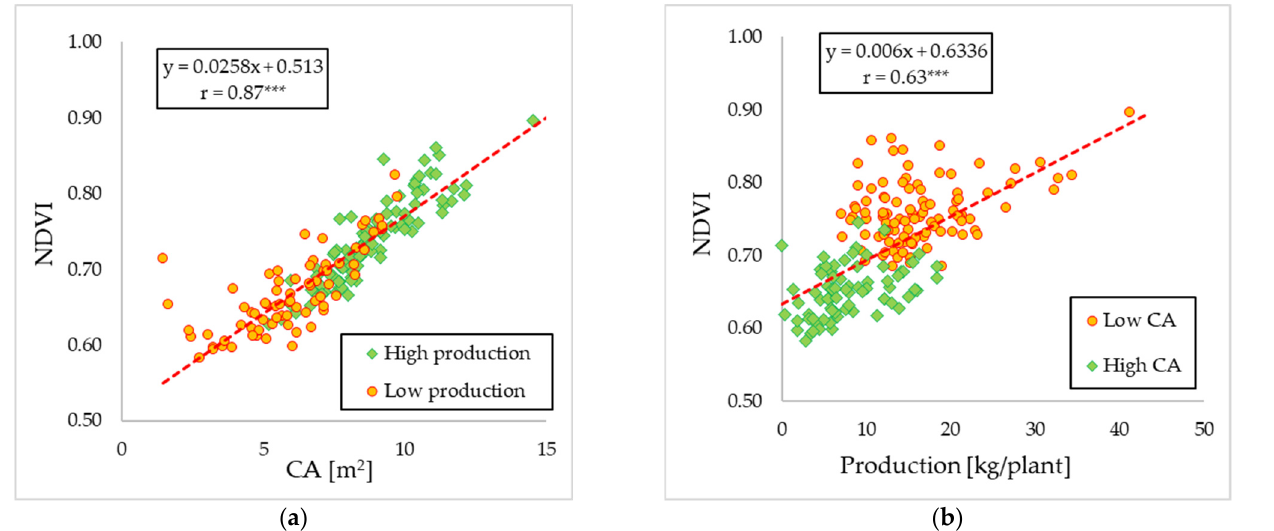
Figure 10. ( a ) Correlation value between NDVI and Canopy area (m 2 ); ( b ) NDVI and Production kg/plant).